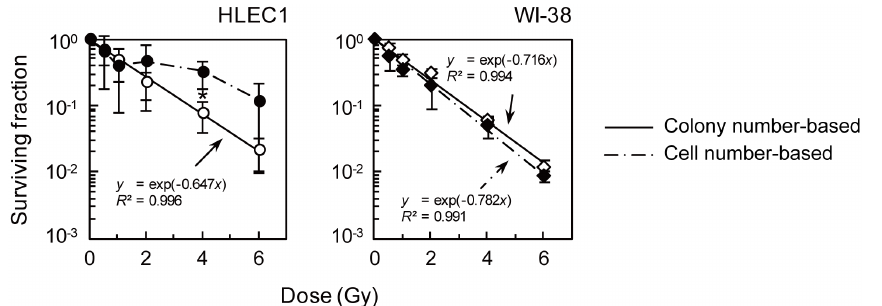
Figure 7. The impact of cell numbers in clonogenic colonies on the surviving fraction in HLEC1 (left panel) and WI-38 (right panel). The general ‘‘colony number-based’’ surviving fraction was calculated from the number of clonogenic colonies divided by the number of plated cells with correction for the plated efficiency. This was compared here with the ‘‘cell number-based’’ surviving fraction that was calculated as the sum of the integrated density of clonogenic colonies (i.e., cell numbers in clonogenic colonies given a linear relationship between the integrated density and cell numbers in each clonogenic colony) divided by the number of plated cells with correction for that at 0 Gy. Colony number-based survival curves (open symbols with solid lines) were taken from Figure 3, and the data of the integrated density of clonogenic colonies presented in Figure S5 were used to obtain cell number-based curves (closed symbols with dotted lines). The data represent means and SD of three independent experiments with quadruplicate measurements. *0.01 # p , 0.05 compared between two types of survival curves at each dose. For WI-38, the difference between the colony number-based survival curve and the cell number-based survival curve was insignificant for all 5 dose points tested ( p . 0.10), indicating that the colony number-based survival fraction is akin to the cell number-based one. For HLEC1, the difference between two types of survival curves reached a statistical significance only at 4 Gy ( p =0.02), but there was clearly a tendency toward the increased surviving fraction at 2 Gy and 6 Gy.